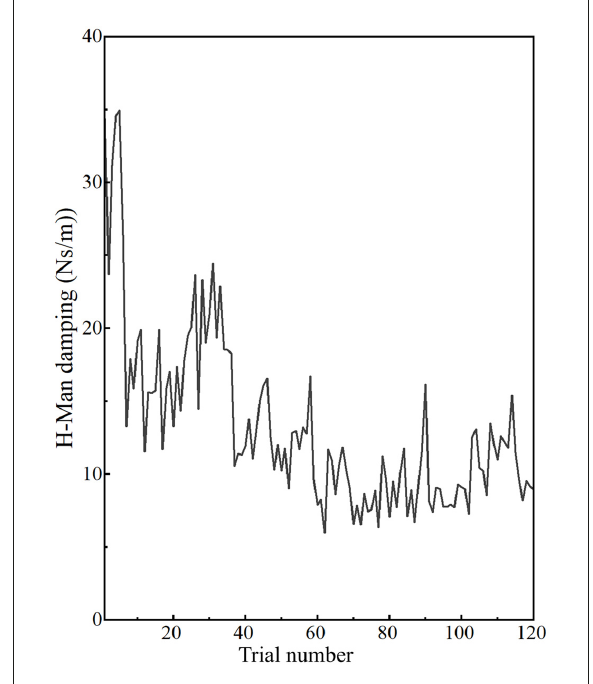
FIGURE6 Damping at the end-effector: as participants adapted to the desired postural target, damping at the end-effector decreased during training. Overall damping varied between 5.99 and 34.96